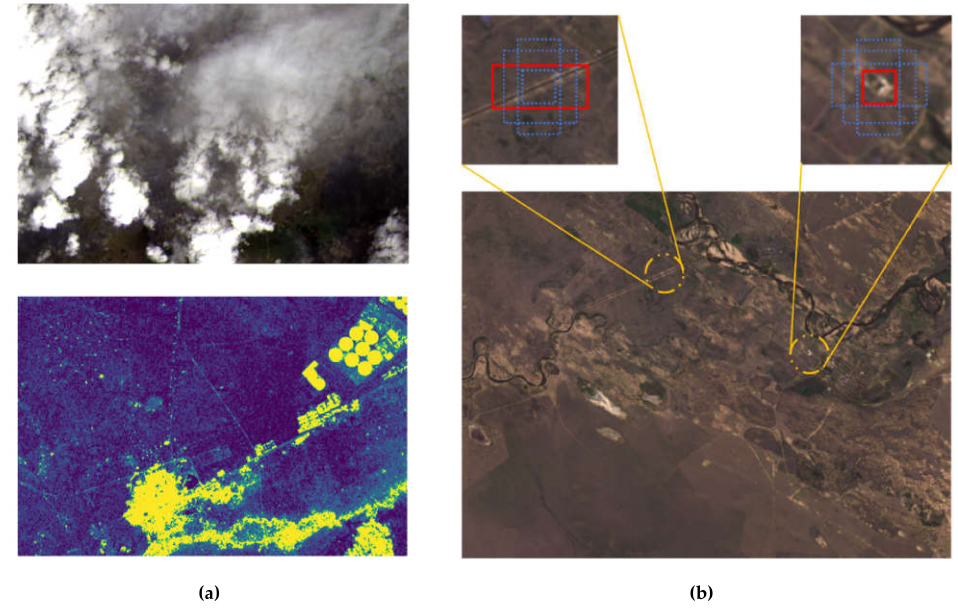
Figure 7. ( a ) Multi-source patch extraction and its application scenarios ( top : MS image influenced seriously by cloud; bottom : SAR image); ( b ) multi-size patch extraction and its application scenarios ( top left : linear ground objects with rectangular patch; top right : small ground objects with small square patch).